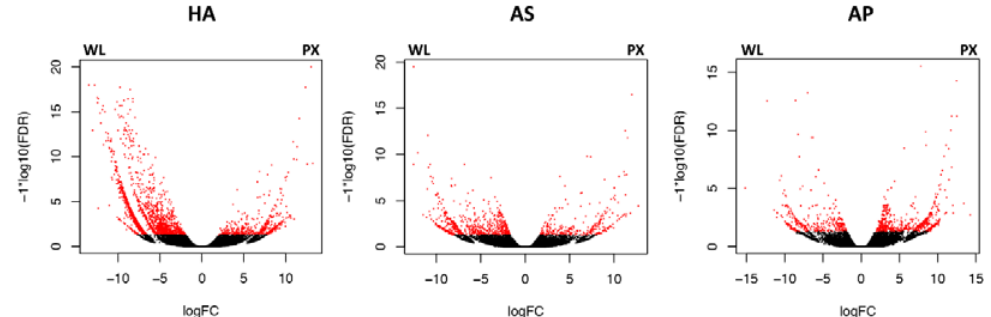
Figure 1. Tissue-specific gene expression. Volcano plots displaying the relative expression levels of transcripts upregulated in the pharynx (PX) compared with the whole larva (WL) in Hysterothylacium aduncum (HA), Anisakis simplex (s.s.) (AS) and Anisakis pegreffii (AP). The x -axis represents the log2 of the expression ratio for each transcript (tissue specific logCPM: whole body counts per million reads, logCPM, CPM); the y -axis represents the log10 of the p -value corrected for the false discovery rate. Red dots represent differentially expressed transcripts with logFDR < 0.05 (at least 2-fold difference in logCPM). Positive logFC values indicate transcripts enhanced in the pharynx subset (PX), while negative values indicate transcripts upregulated in the whole larva (WL).